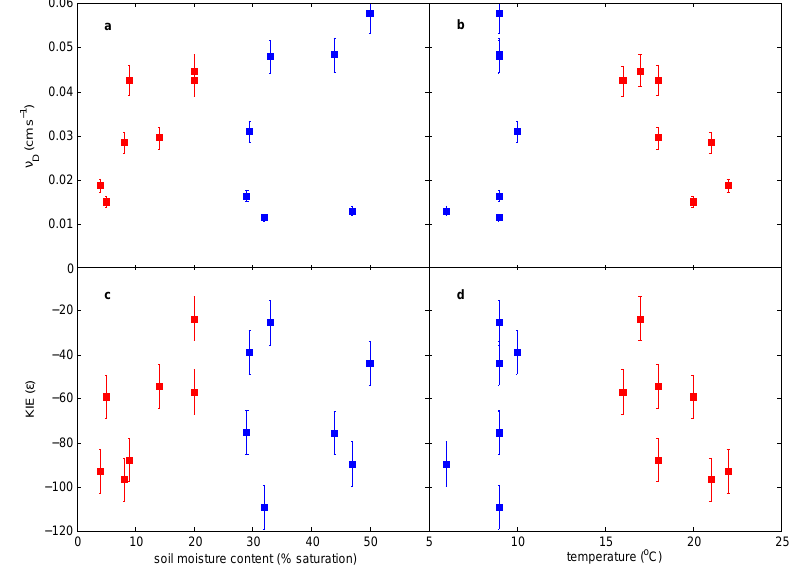
Fig. 2. Deposition velocity (a, b) and kinetic isotope effect (c, d) plotted versus soil moisture (a, c) and temperature (b, d) during the chamber experiments during the winter season (blue squares) and summer season (red squares).